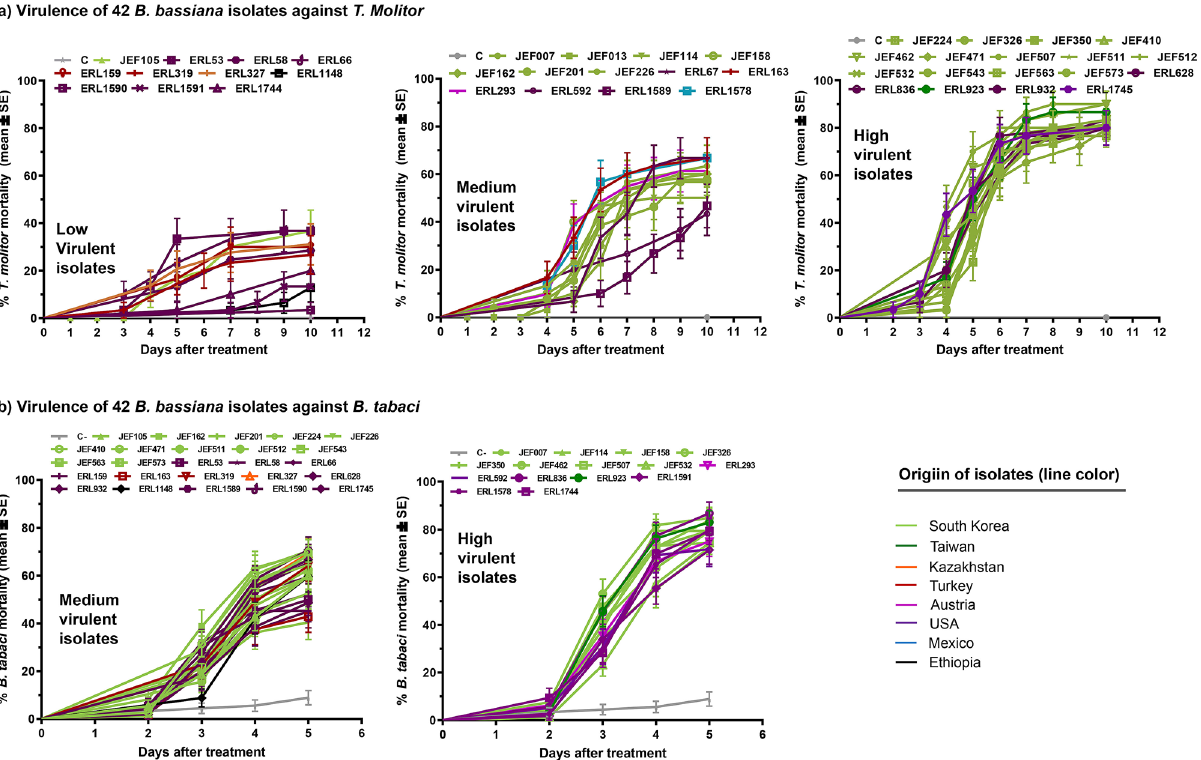
Figure 3. Virulence of 42 B. bassiana isolates against T. molitor ( a ) and B. tabaci ( b ) . Virulence against larvae of the two species is represented as cumulated mortality per day. Isolates killing between 0 and 40% are considered low infective, those killing between 41 and 70% are medium infective isolates and high infective isolates are those killing between 71 and 100%. The mortality curves were plotted using GraphPad Prism 5 (Inc., San Diego, CA,